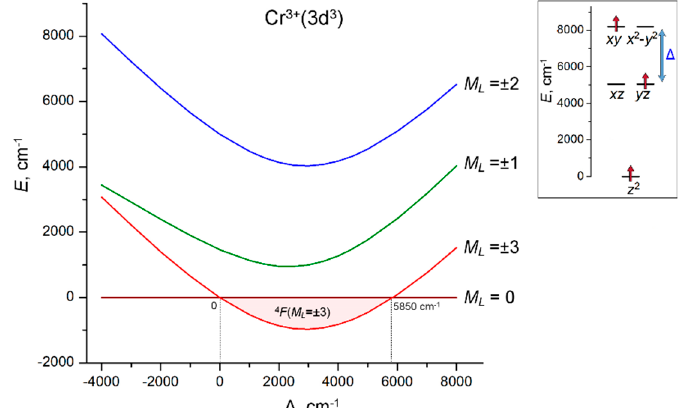
Figure 3. Dependence of the energies of the 4 F ( M L ) LF states of Cr 3+ (3d 3 ) ion on the energy separation Δ = E ( xy , x 2 − y 2) − E ( xz , yz ) between the ( xy , x 2 − y 2) and ( xz , yz ) sets of 3d orbitals. The range of the stabilization of the 4 F ( M L = ±3) ground state (0 ≤ Δ ≤ 5850 cm − 1 ) is marked with light pink. Inset: the LF splitting pattern of 3d orbitals, E ( z 2 ) = 0, E ( xz , yz ) = 5000 cm − 1 (fixed) and E ( xy , x 2 − y 2) = 5000 cm − 1 + Δ (variable). LF calculations were done with atomic parameters B = 650, C = 3000 and ζ = 250 cm − 1 .